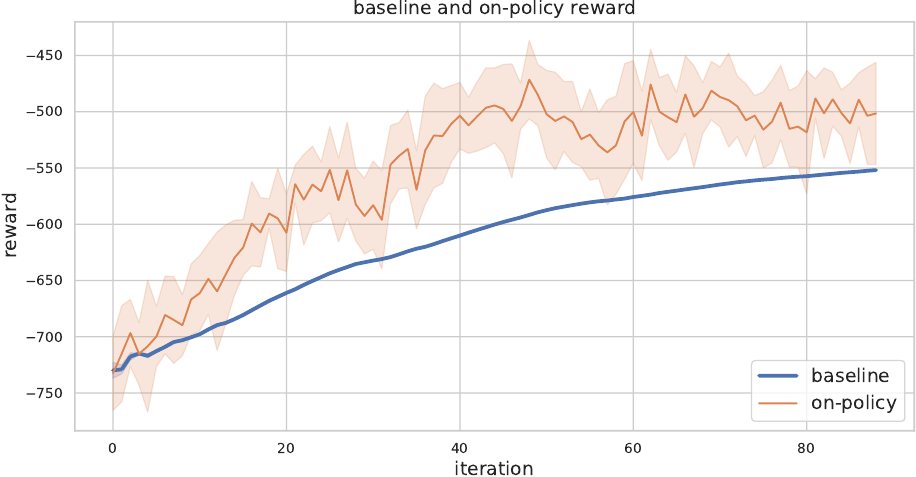
Figure 9. On-policy reward and baseline reward for 5 robots and 50 tasks problem instance while training. We recorded all the simulated results and aggregated them by 5 episodes. The colored region represents 95% confidence interval.